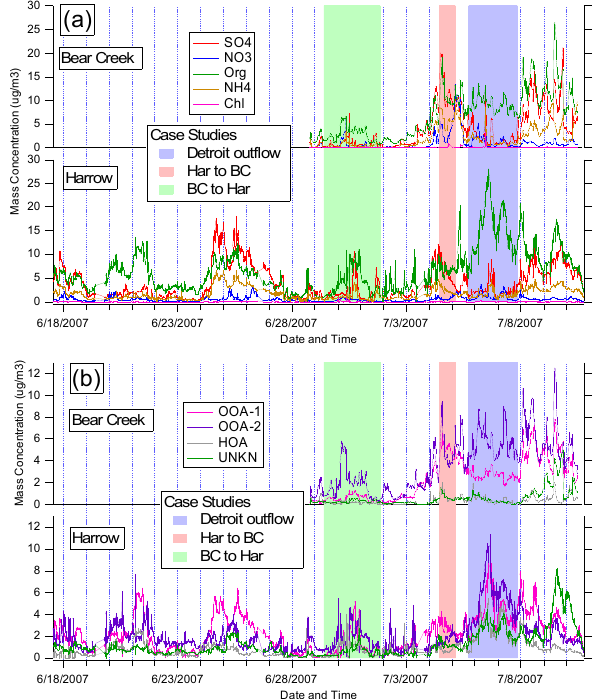
Fig. 3. AMS time series of inorganic species and total organics (a) and organic PMF factors (b) . Shaded regions denote case study periods discussed in the